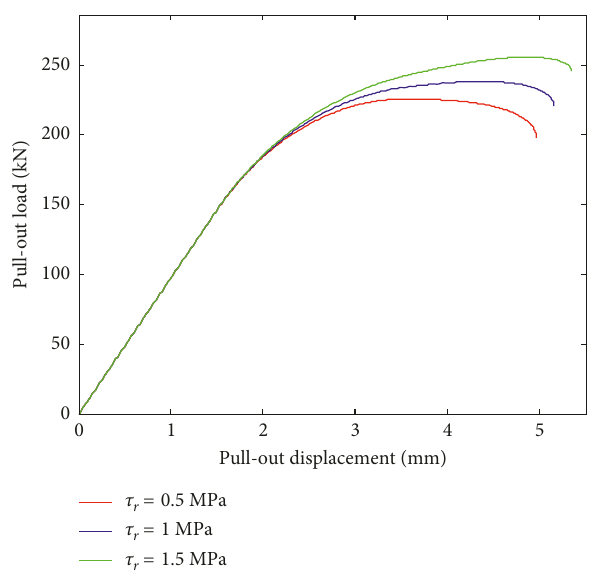
Figure 14: Load transfer performance of rock bolts when the residual shear strength of the bolt/grout interface was